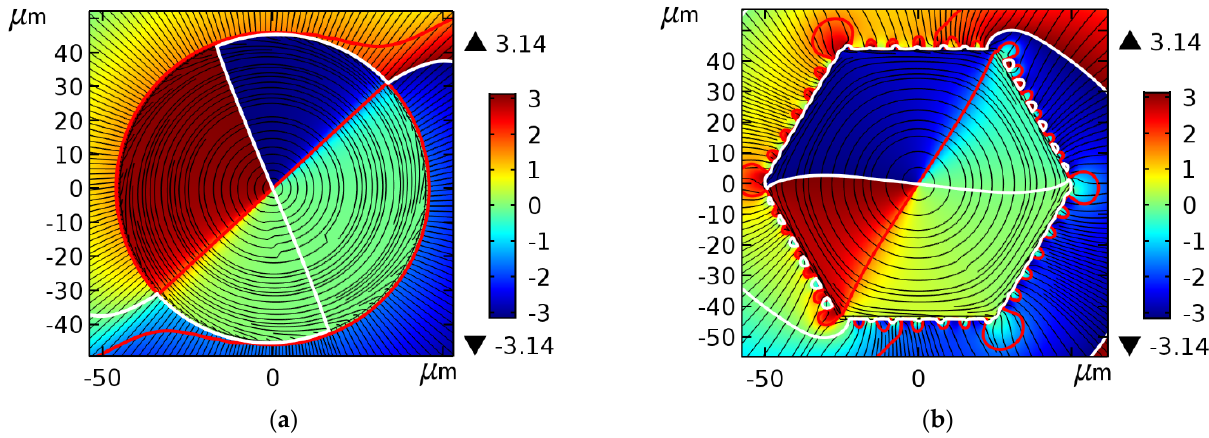
Figure 6. Phase distribution of the axial electric field component at a wavelength of 3.39 µ m for: ( a ) a capillary with a wall thickness of 1 µ m ( b ) hollow hexagon with a wall thickness of 1 µ m. Black lines are streamlines of the transverse component of the Poynting vector of the fundamental air core mode. Thin red and white lines correspond to the condition that the real (red) and imaginary (white) parts of the axial component of electric field being equal to zero. The phase changes from − π (dark blue) to π (dark